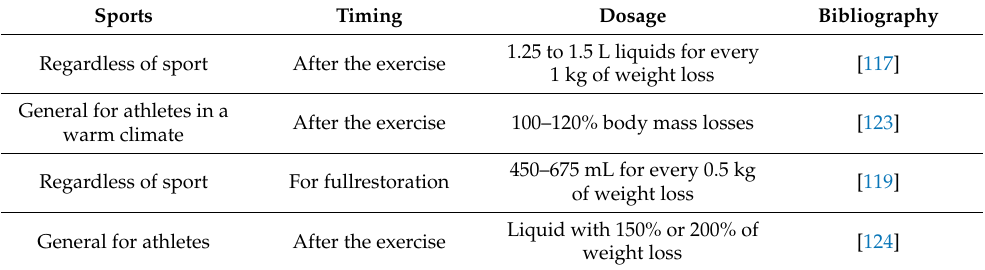
Table 8. Fluid intake after the